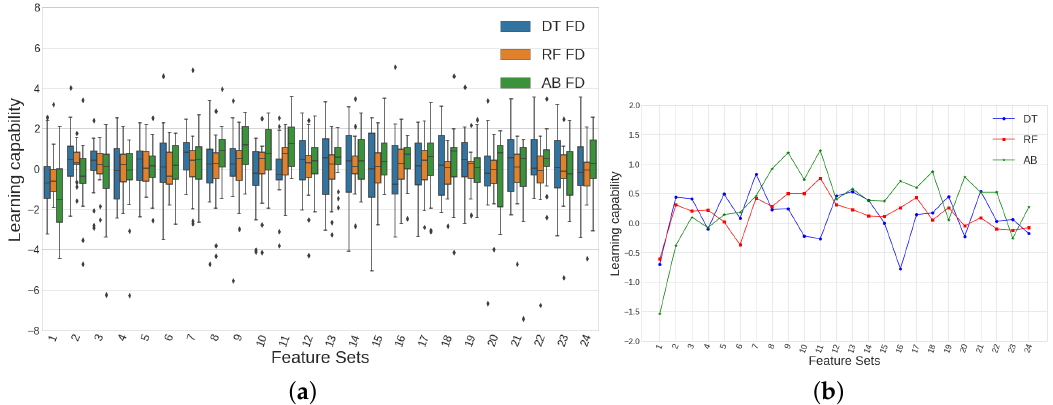
Figure 19. ( a ) AdaBoost classifier performs better than RF and DT, possibly because it takes advantage of the fractional differences informative power in a more efficient way than the rest of the classifiers, since AdaBoost is based on one-predictor decision tree (the most informative one among all predictors given). ( b ) Line plots showing median values of learning capability show how the use of AB outperforms both DT and RF results in 13 out of 24 total feature